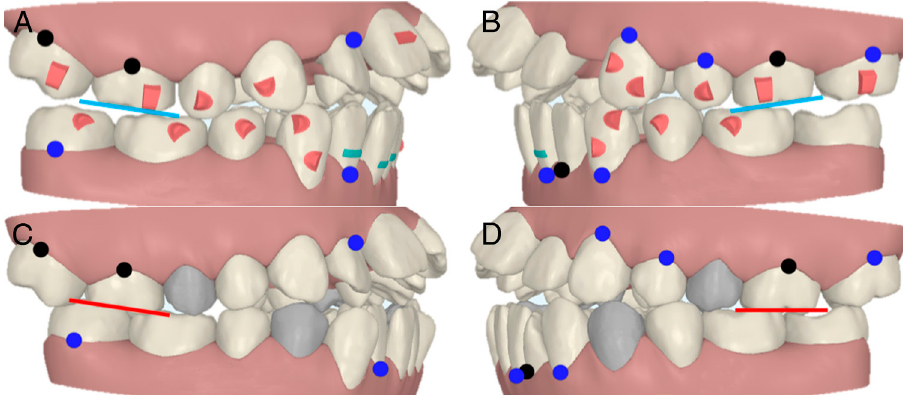
Figure 16. Overcorrection to keep the crowns inclined distally. (A-B) during treatment. (C-D) before